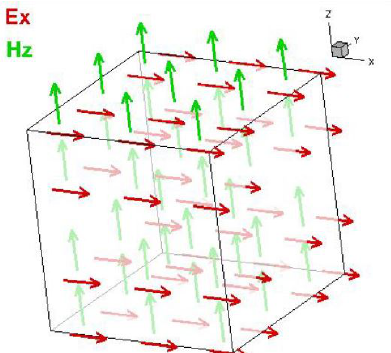
FIGURE 7: FEM method. Location of the electric field and magnetic field basis function for r = 2 with respect to the x axis and z axis respectively.